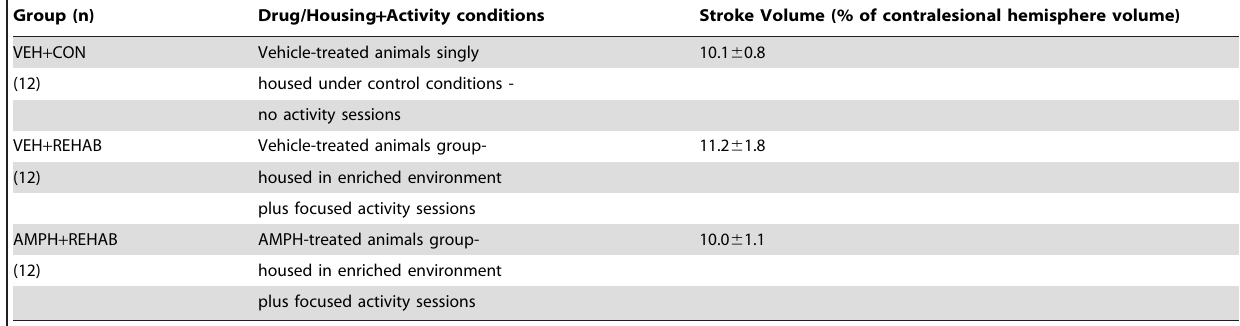
Table 1. Lesion Analysis among Treatment